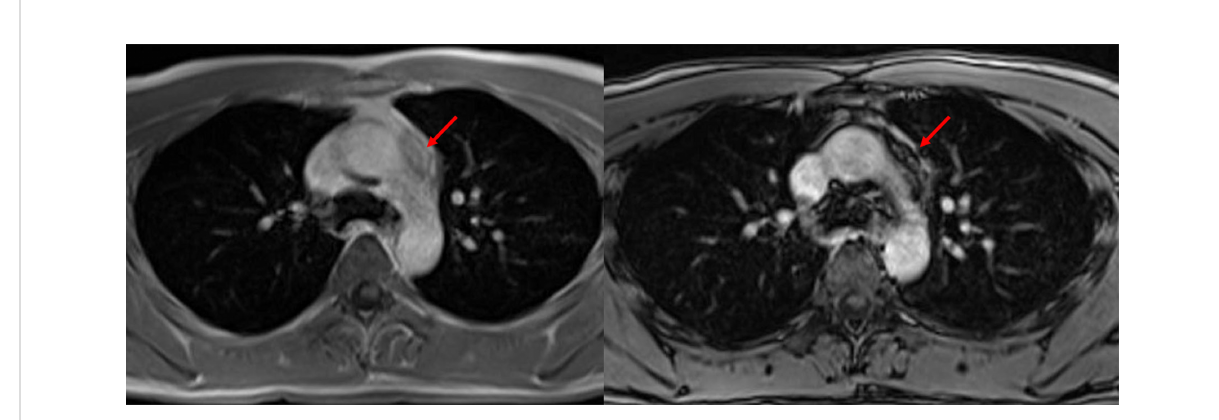
FIGURE 5 Sclerosing thymoma. A 27-year-old male patient with sclerosing thymoma (arrow). Placing a ROI in the same area on in-phase (left) and opposed-phase (right) T1-weighted images to identify SII, which was 64.6%.